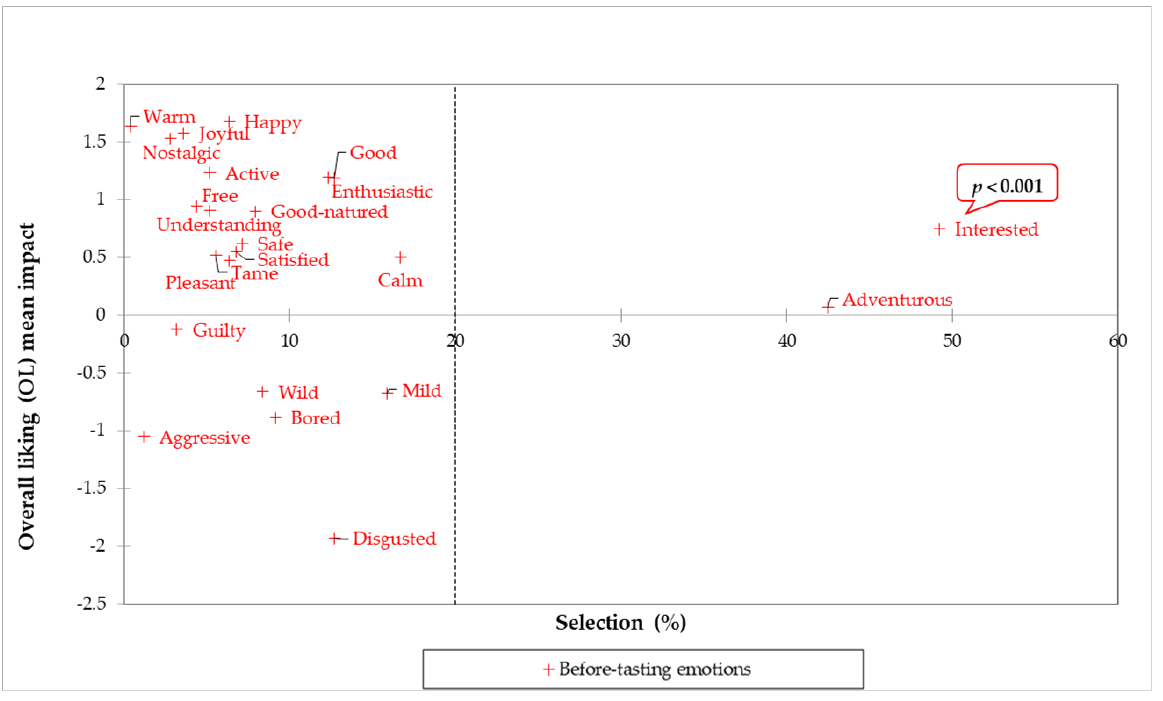
Figure 7. Treatments ’ before-tasting overall liking (OL) mean impact (mean OL difference from present vs. absent categories for each emotion with a 20% population threshold size) vs. significant ( p < 0.05, 2-sample t -test) emotions in the before-tasting moment (%) from n = 84 consumers. Before-tasting emotions and OL from treatments (Figure 1) were pooled together for the analysis.